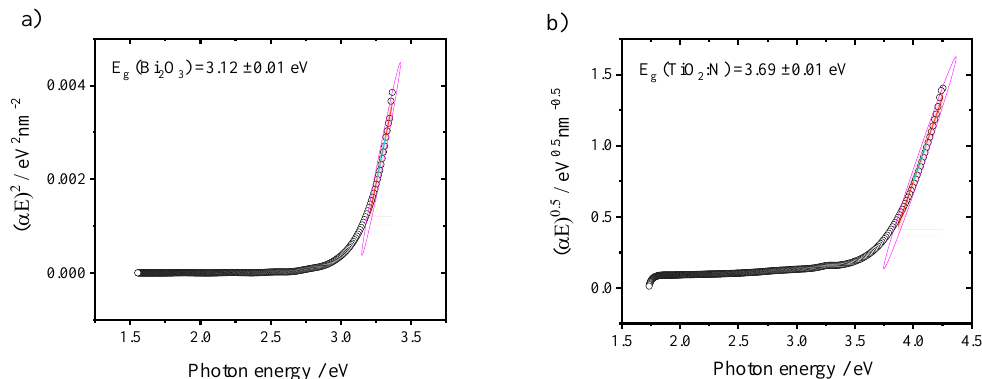
Figure 8. Tauc plots for the extrapolation of the ( a ) Bi 2 O 3 (direct) and ( b ) TiO 2 :N (indirect) band-gaps.